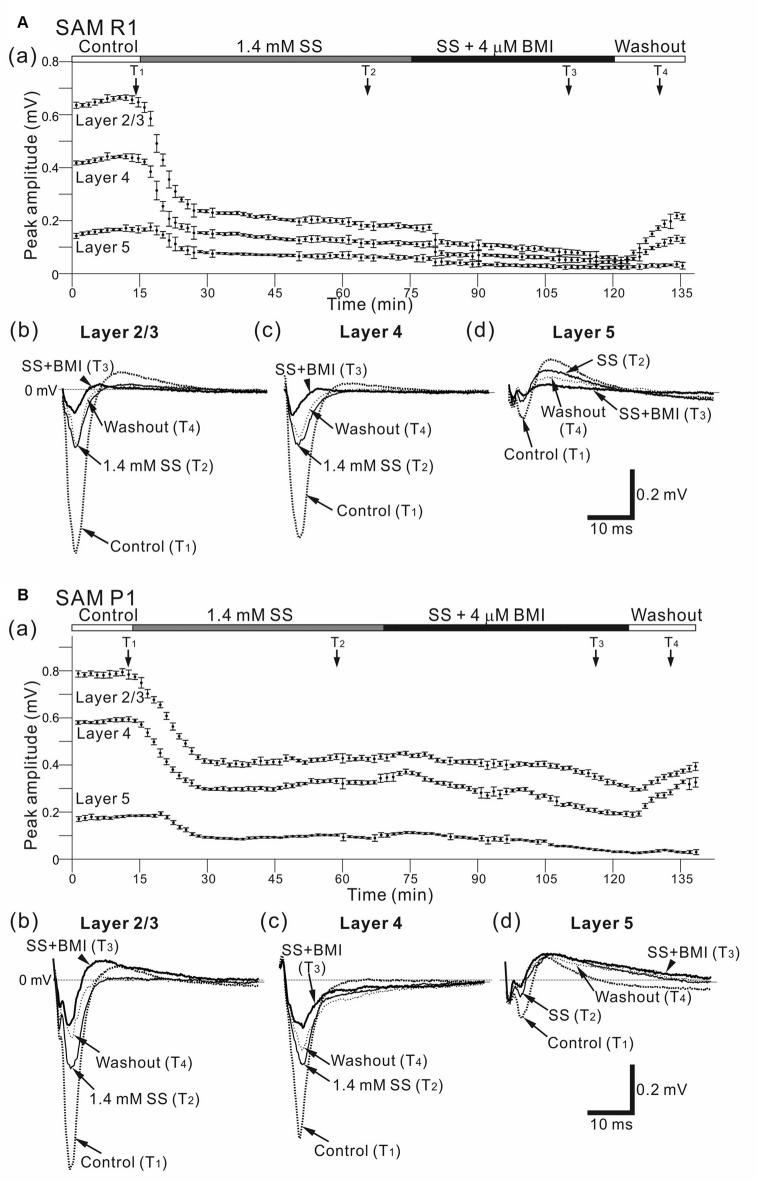
Effects of individual and simultaneous application of SS and BMI on cortical LFP responses evoked by stimulation at one site in L4. (A) Representative example of an older SAMR1 mouse (13-month old). In (a), following 1.4 mM SS administration (T2), the superfusion of 4-μM BMI gradually decreased the negative peaks of LFP amplitudes (T3) in the three layers (L2/3, L4 and L5) compared with post-SS and control (T1). At T4 the drug had been washed out. Typical LFP responses in L2/3 (b), L4 (c) and L5 (d) in each condition are illustrated. Durations of the four (control, post-SS, SS/BMI and washout) conditions are given in the white, gray, black and white bars on the top, respectively. (B) A representative example of an older SAMP1 mouse (13-month old). As in Part (A), the time courses of peak amplitudes in the three layers are shown in (a). The waveforms at the four time points (T1, T2, T3, and T4) in the three layers (b–d) are illustrated under the four conditions.